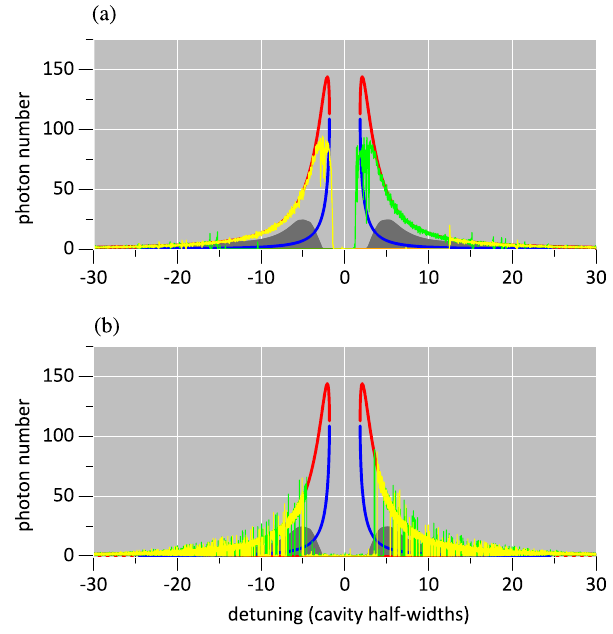
FIG. 5. Sample quantum trajectories show dynamical sym- metry breaking as the drive detuning Δ ω = κ is scanned. Time-dependent photon-number expectations are superposed on the plot of Fig. 4(b), for scan times (one direction) of (a) κ T ¼ 6 × 10 2 and (b) κ T ¼ 6 × 10 4 . Yellow (green) curves plot the scan from left to right (right to